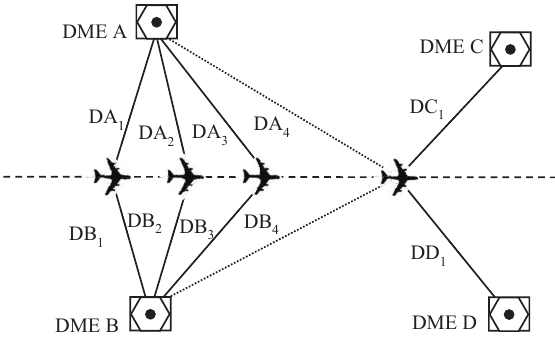
Figure 3. Multiple DME/DMEs approach